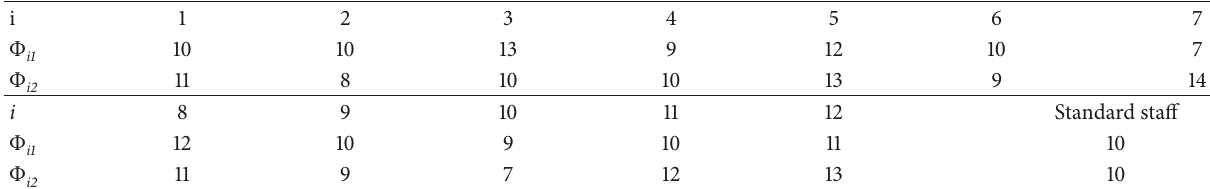
Table 6: The consumption rates of nonrenewable resources.